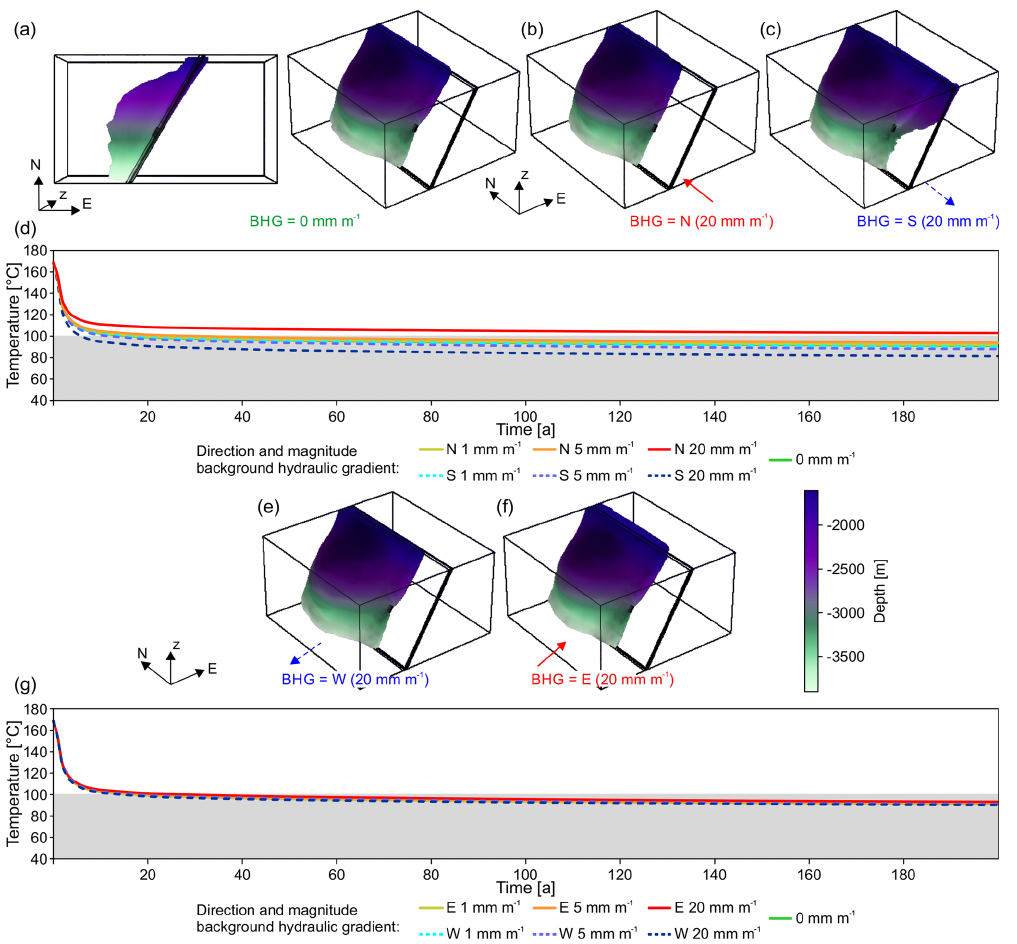
Figure 8. Temperature development and shapes of the HDI for faults that consist of an impermeable fault core surrounded by two damage zones. In (a) , (b) , and (c) , the shapes of the HDI after 100 years for fault-parallel BHGs are shown. The HDIs are restricted to the east by the impermeable fault core but extend to the west into the host rock at the injection well. Panels (d) and (g) show the temperature development over time of the produced fluid and contain the results of 13 individual simulations. Panel (d) shows that the orientation and magnitude of the BHG have comparable small impact on the temperature development. After a sharp initial drop, the temperatures stabilize after about 10 years. Only in the case of the highest northwards-directed gradients does the temperature stay above 100 ◦ C. In (e) and (f) , shapes of the HDI for BHGs normal to the strike of the fault after 100 years are shown. The HDI shapes are almost identical to those for BHGs parallel to the fault. (g) The temperature developments for BHGs normal to the fault are similar for all tested magnitudes, i.e. the 100 ◦ C threshold is reached after 10–20 years and the temperatures stabilize just below the